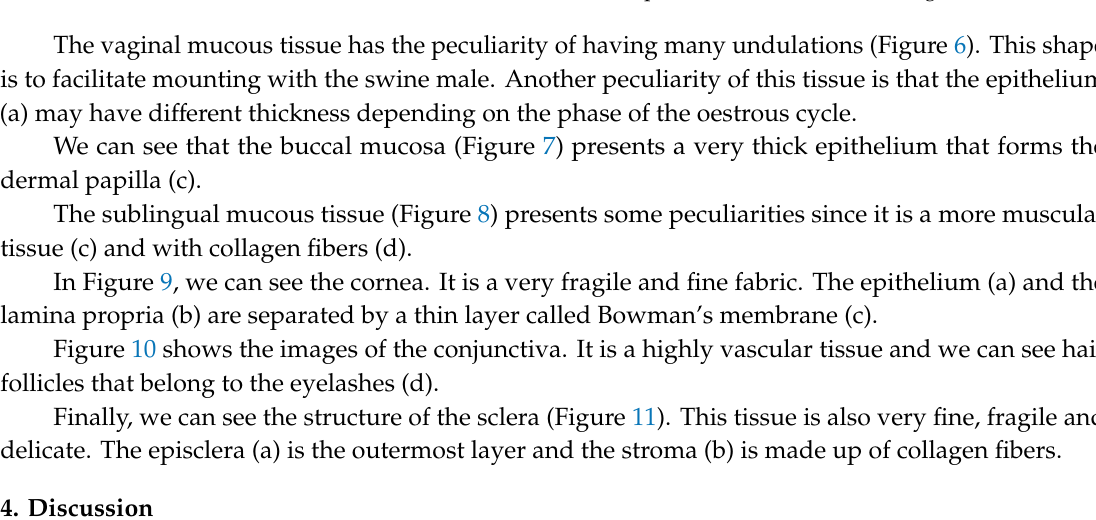
Figure 11. Histological images of sclera. ( A ): Untreated sclera observed at 400 × and ( B ): Sclera treated with CP-Sat observed at 400 × . a: stratified flat keratinized episclera and b: stroma (collagen fibers).